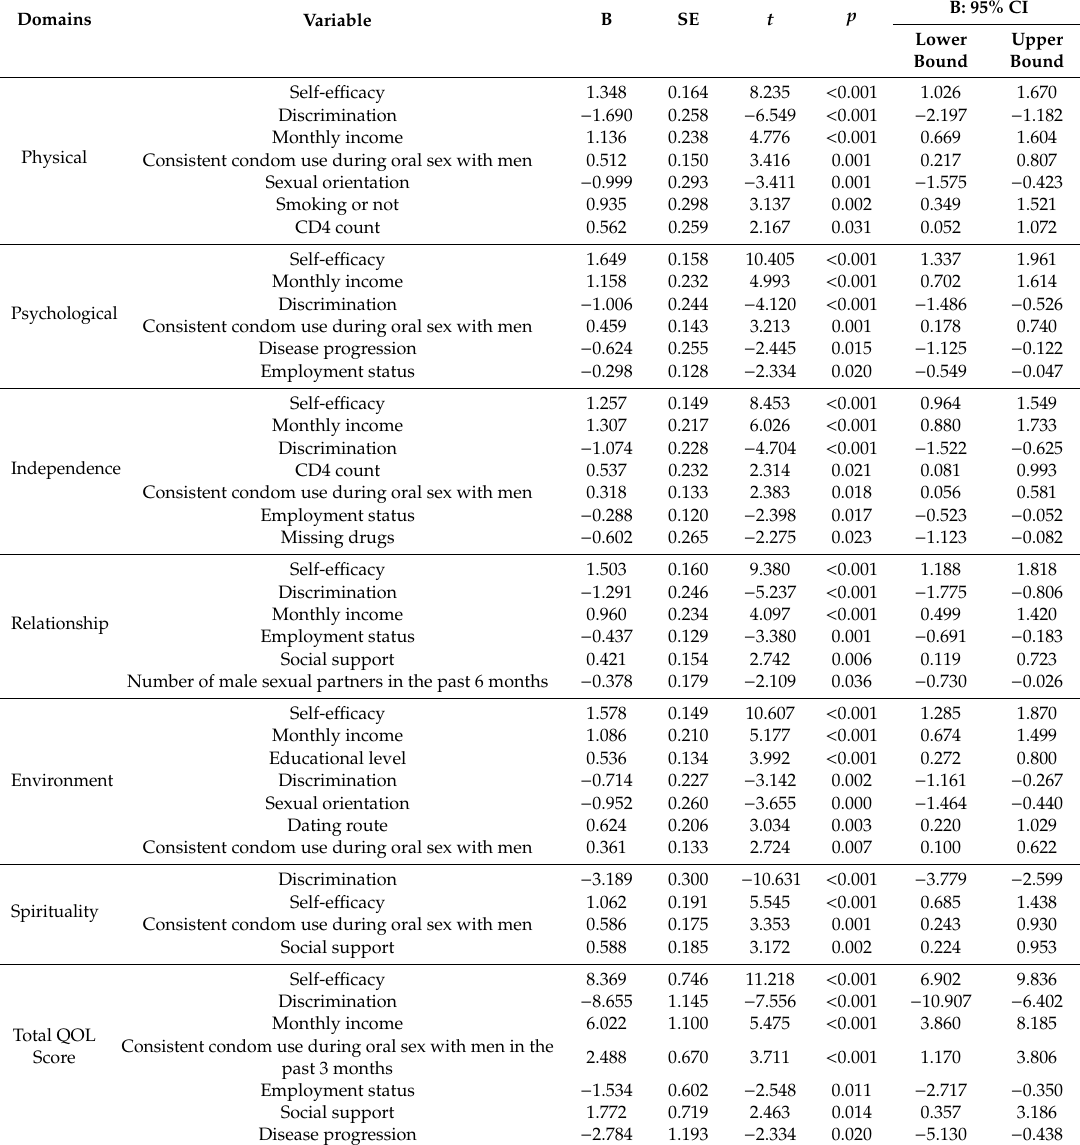
Table 6. Multiple regression analysis of factors associated with quality of life ( n =